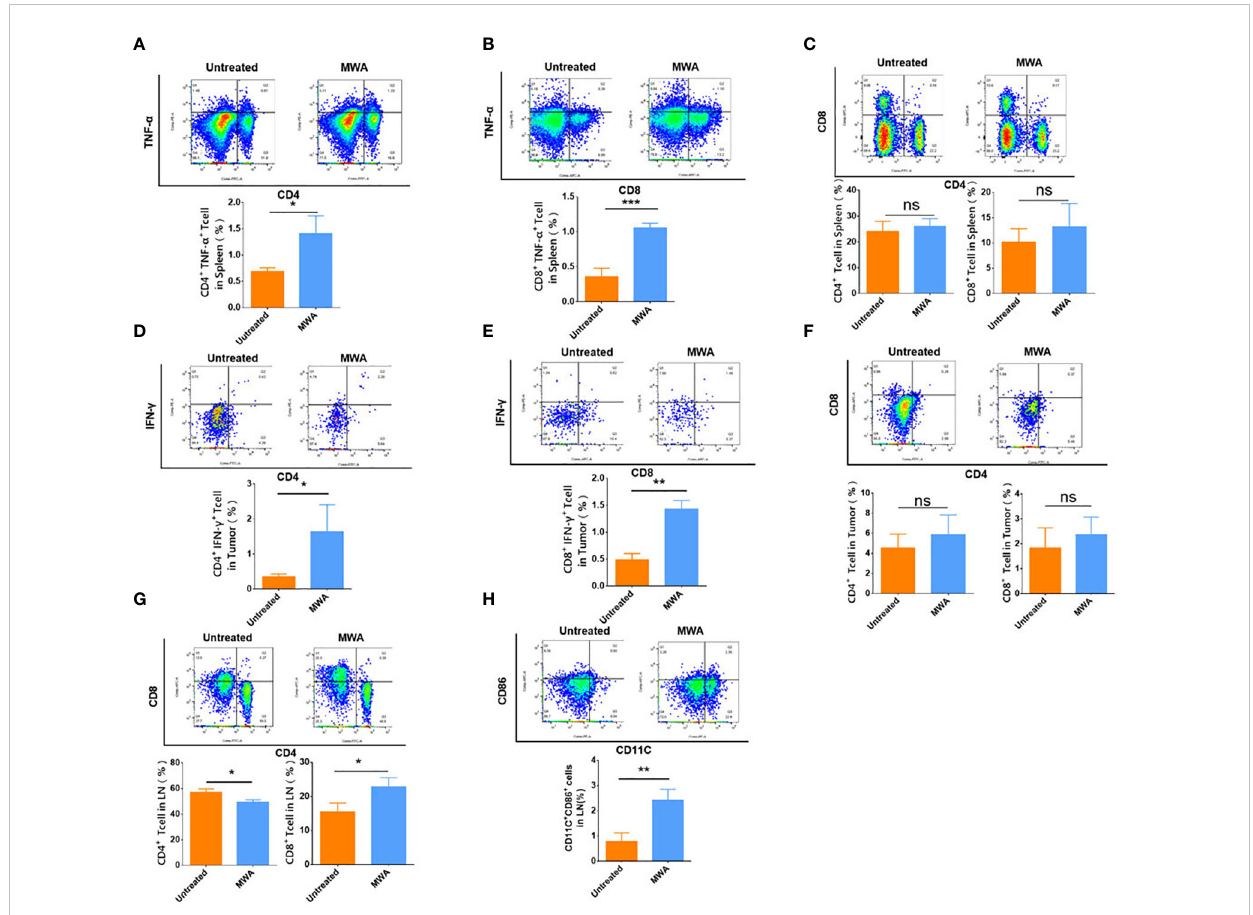
FIGURE 3 MWA at 3 w – 3 min activated systemic immune response in CT26 tumor-bearing mice. The percentages of CD4 + TNF- a + T-cells (A) and the percentages of CD8 + TNF- a + T cells (B) in the spleen were both determined after MWA. (C) The percentages of CD4 + and CD8 + T cells in the spleen were determined after MWA. The percentages of CD4 + IFN- g + T cells in the abscopal tumor (D) and CD8 + IFN- g + T cells in the abscopal tumor (E) were determined after MWA. (F) The percentages of CD4 + and CD8 + T cells in the abscopal tumor were obtained after MWA treatment. (G) The percentages of CD4 + and CD8 + T cells in the axillary lymph node were also computed following MWA. (H) The percentage of CD11c + DCs in the axillary lymph node from mice treated with MWA was determined. ns, p > 0.05; *p < 0.05; **p<0.01; ***p <